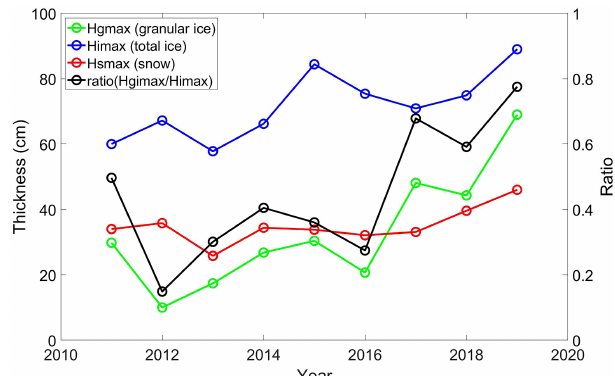
Figure 10. Seasonal maximum snow depth, granular ice thick- nesses, congelation ice thicknesses, and the date when those values were observed.